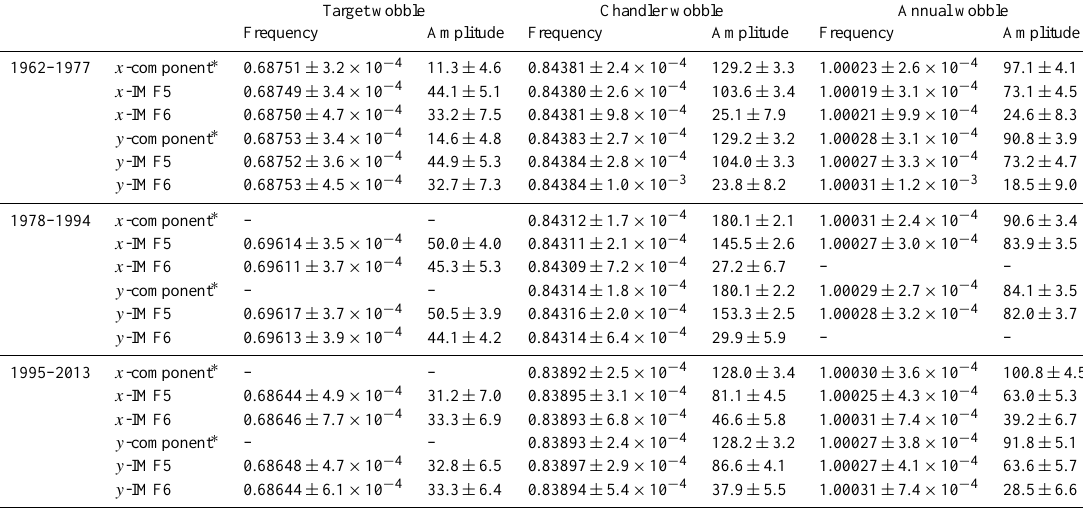
Table 1. The observed frequencies (cpy) and amplitudes (mas) of the CW, AW and the target wobble. Target wobble Chandler wobble Annual wobble Frequency Amplitude Frequency Amplitude Frequency Amplitude